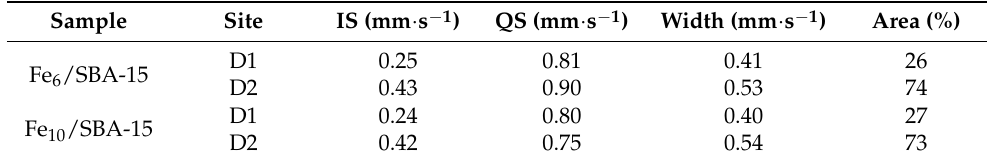
Table 2. Hyperfine parameters obtained from Mössbauer spectra recorded at 27 ◦